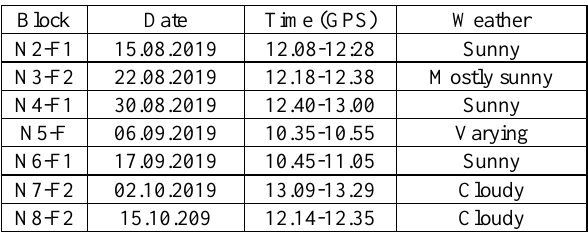
Table 1. Information about data capture flights.